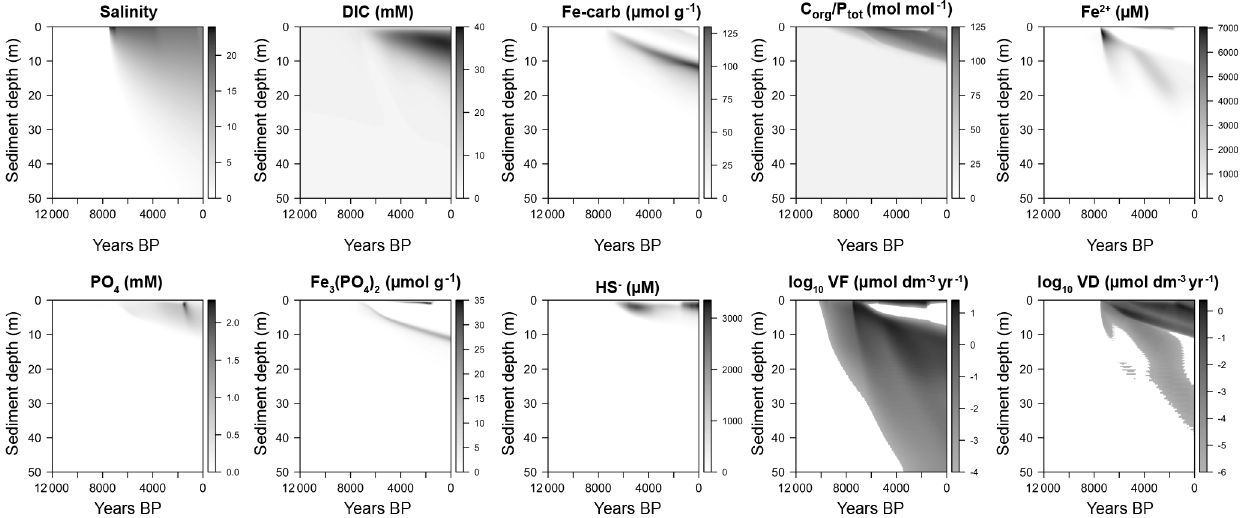
Figure 11. Modeled evolution of salinity, dissolved inorganic carbon (DIC), Fe carbonates (Fe-carb), C org / P tot , dissolved Fe (Fe 2 + ), phosphate (PO 4 ), vivianite (Fe 3 (PO 4 ) 2 ), dissolved sulfide (HS − ) and rates of vivianite formation (VF) and vivianite dissolution (VD) in the Bornholm Basin sediments from 12000 years BP to the present. A white color in the plots of VF and VD indicates values below the scale bar minimum. The increase in salinity at 7500 years BP marks the onset of the lake–marine transition. The subsequent deposition of sediment in a brackish–marine environment and the related changes in the porewater chemistry led to major changes in solid phase chemistry as a function of sediment depth and time. The distinct bands of Fe carbonate and vivianite (Fe 3 (PO 4 ) 2 ) minerals formed in the sediments are particularly